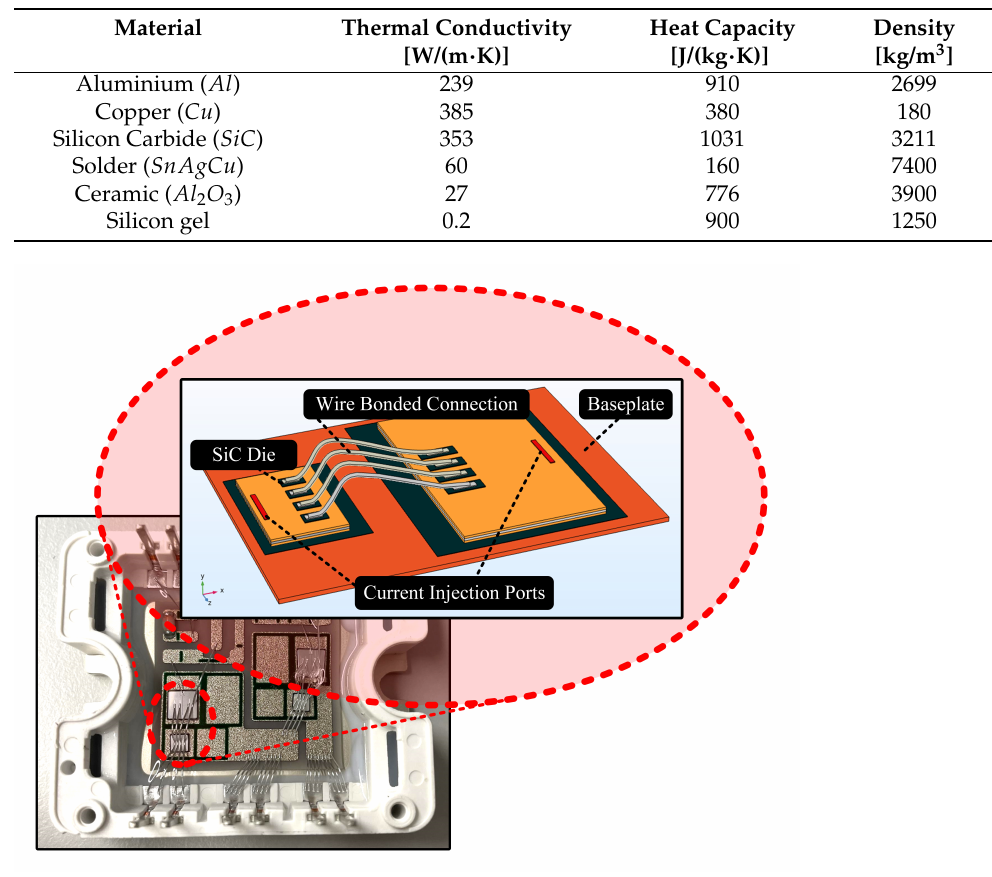
Figure 5. 3D FEM model of the case study 1200 V/55 A SiC MOSFET power module in the wire bonded connection